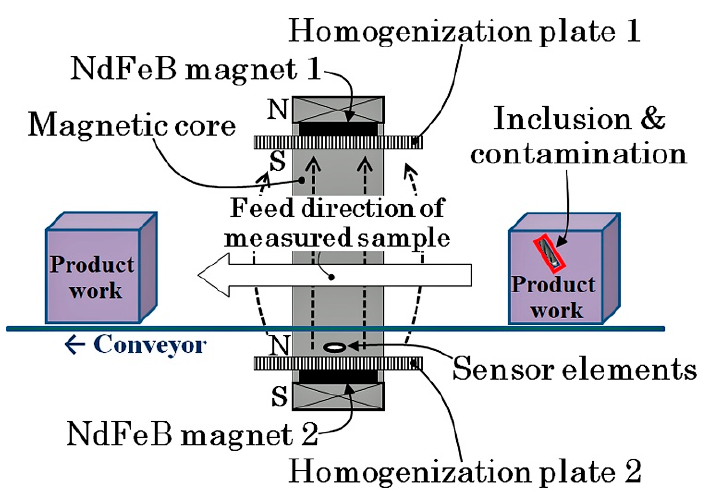
Figure 1. Schematic illustration of the concept at the basis of the measurement system (from [12]).